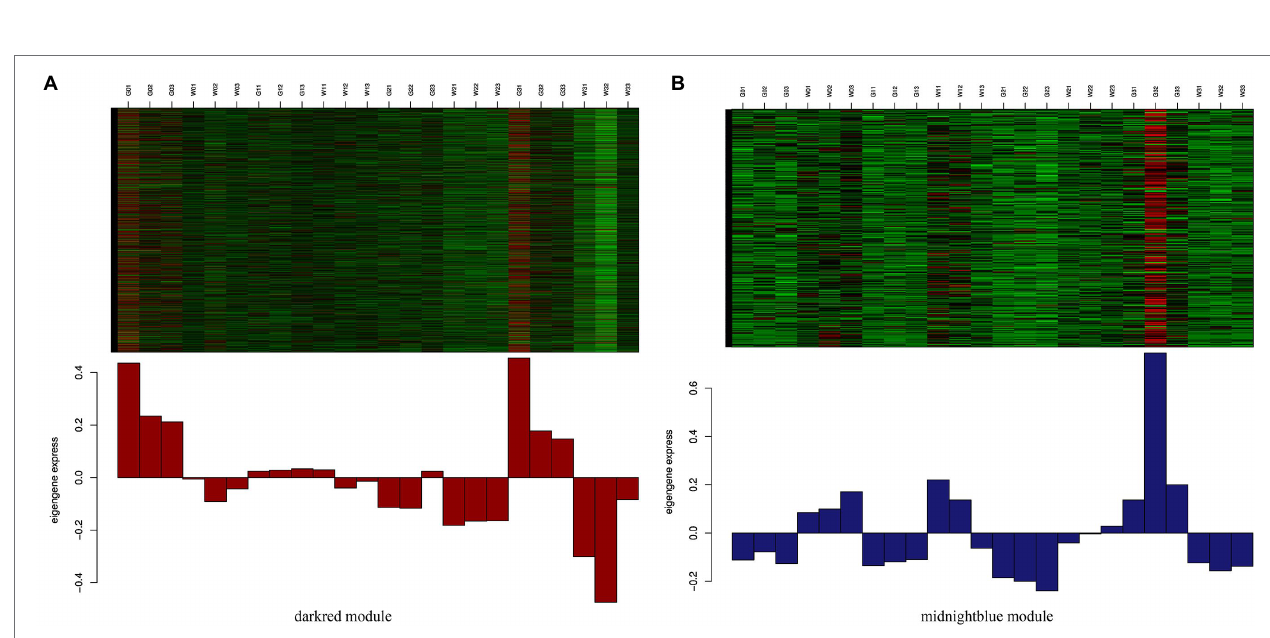
FIGURE 5 | Details of the modules constructed via weighted gene co-expression network analysis (WGCNA). (A) The cluster dendrogram of the 23,977 genes. (B) The number of genes in each module which construct by (A) . (C) The heat map of correlation among all modules.